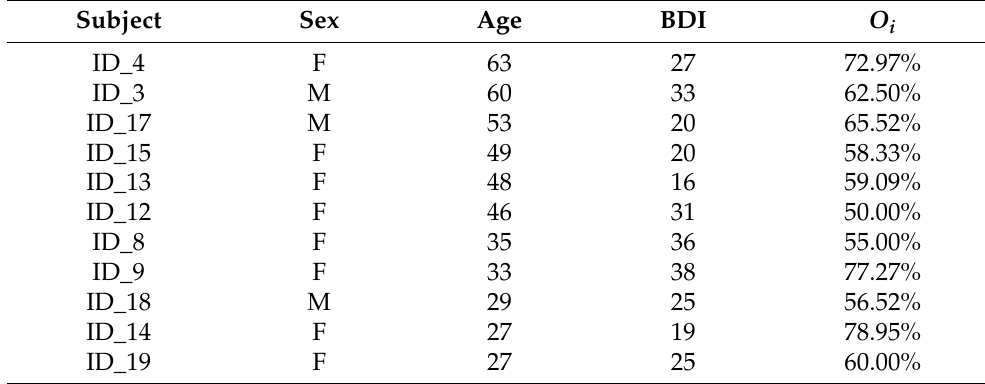
Table 6. Inversion percentages ( O i ) in depressed